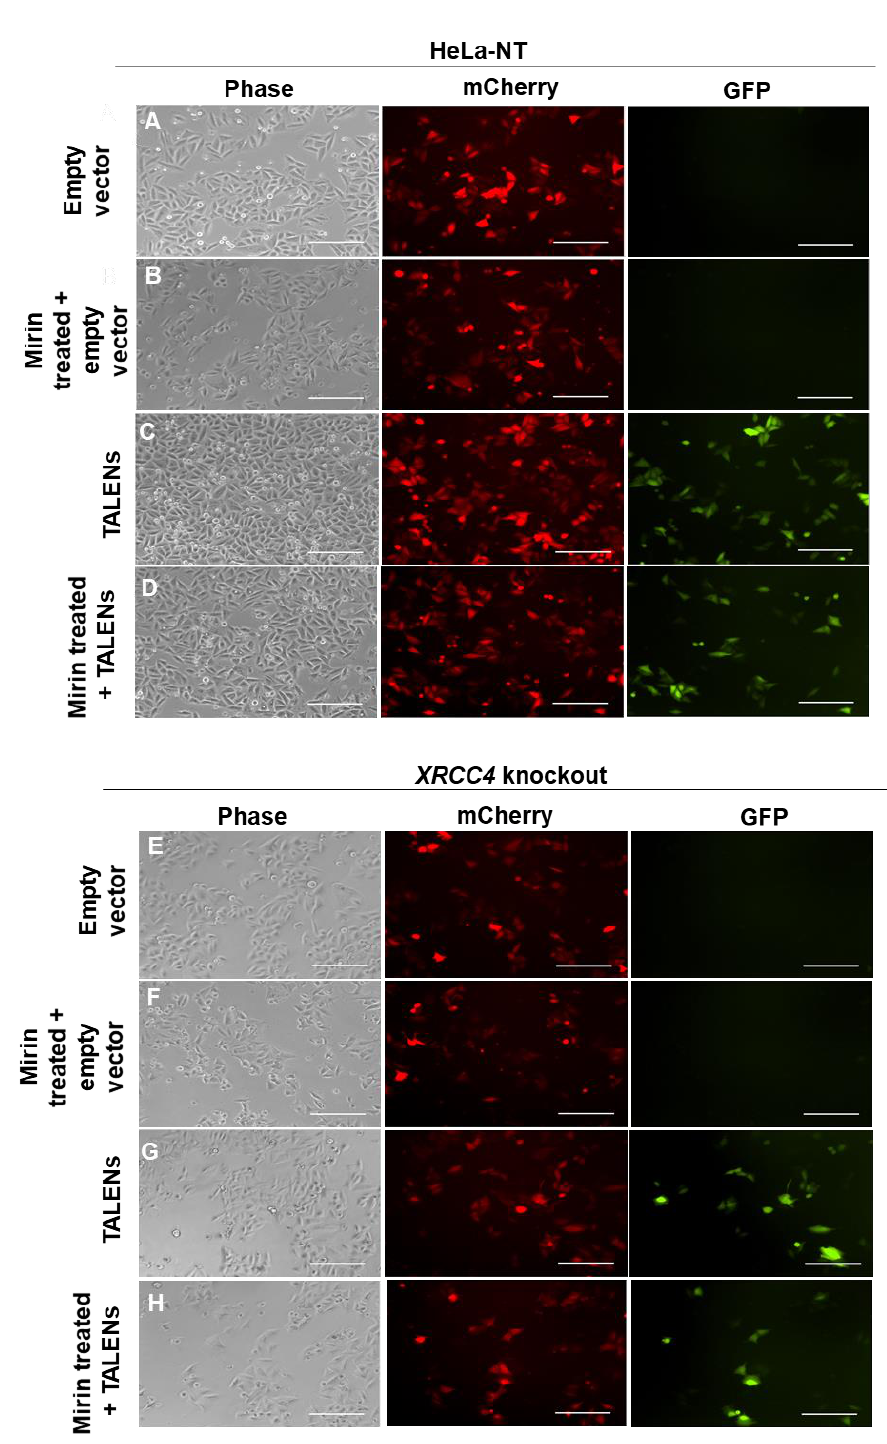
Figure 2. DNA DSB repair when either XRCC4 is knocked out, MRE11 is inhibited, or both. Repre- sentative fluorescence microscopy images of cells following various treatments (treated with 100 µ M mirin where indicated) for HeLa-NT ( A – D ) and XRCC4 knockout ( E – H ) cells. Cells co-transfected with a TALEN reporter plasmid (expressing mCherry) along with either empty vector or TALEN plasmids produced GFP + cells indicating DNA repair editing had occurred. Cells were analyzed 48 h post-transfection and representative images are shown. TALEN reporter with empty vector ( A , E ), empty vector with mirin ( B , F ), TALEN plasmid ( C , G ), TALEN plasmid with mirin ( D , H ) are shown. Scale bar = 100 µ m. Representative images from triplicate experiments are